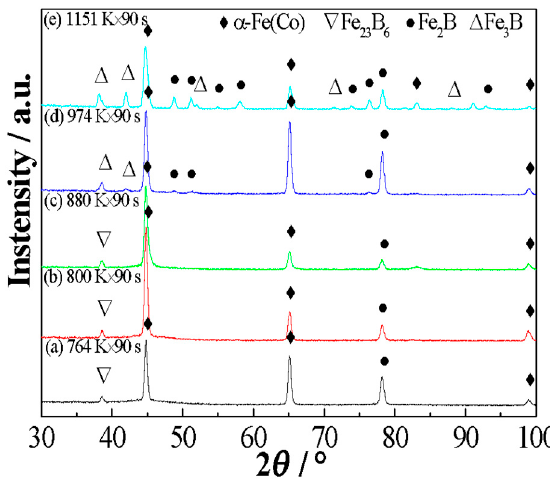
Figure 3. Structural evolution of the (Fe 0.4 Co 0.6 ) 79 Nb 3 B 18 alloys annealed at different temperatures for 90 s.